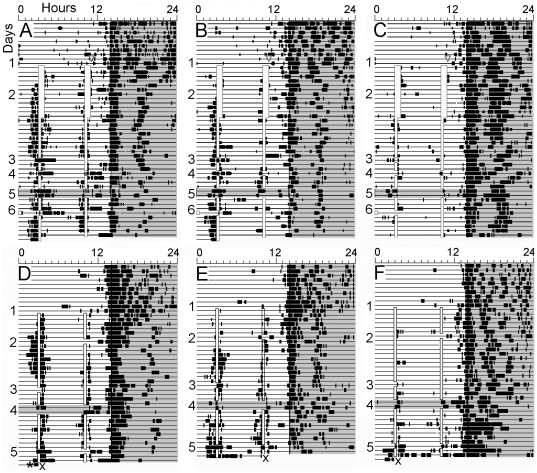
Wheel running of representative rats in

Experiment 3

. Panels A–C. Rats from cohort A. Experimental conditions are numbered to the left of each actogram: (1) 37-h food deprivation. (2) Two daily meals, denoted by opaque vertical bars. (3) Meal 1 omitted. (4) Both meals omitted. (5) Both meals omitted for 2 days in DD. (6) Meal 1 advanced by 3-h. Panels D–F. Rats from cohort B. Experimental conditions: (1) 37-h food deprivation. (2) Meal 2 omitted. (3) Meal 1 omitted. (4) Both meals omitted for 2 days in DD. (5) Both meals omitted in LD.